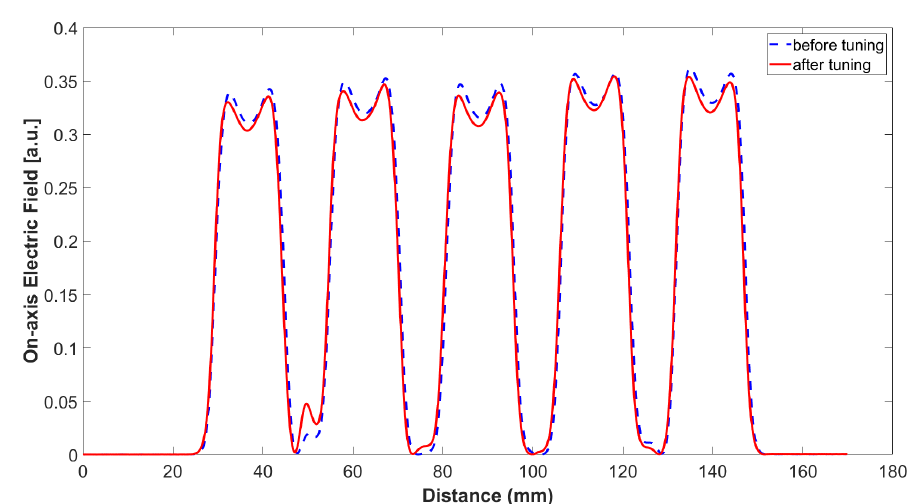
Figure 11. On-axis electric field from low-power RF tests before tunign (in blue) and after tuning process (in